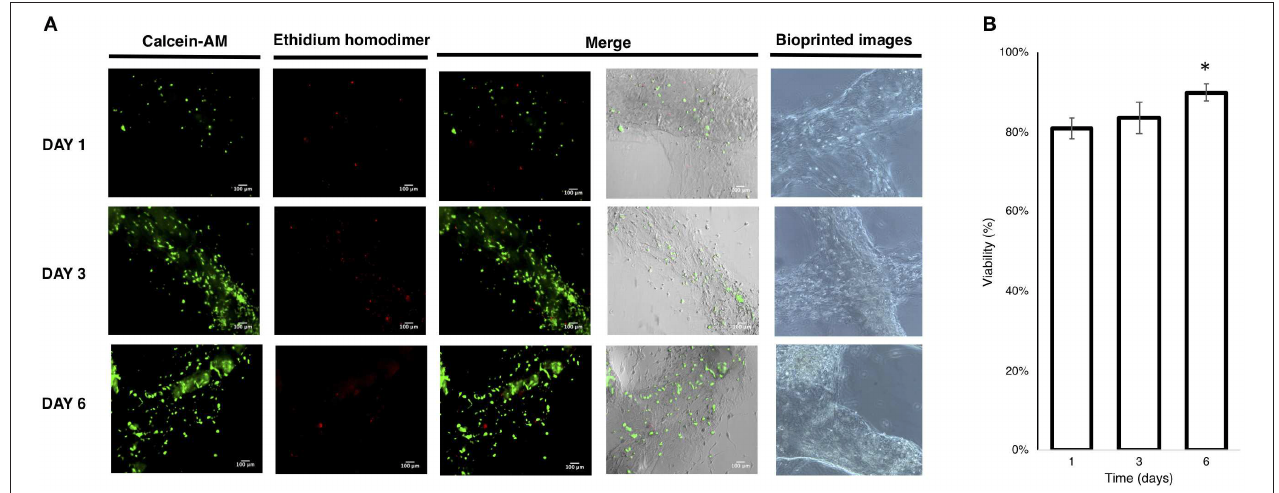
FIGURE 7 | (A) Live/Dead imaging of bioprinted U87 cells; (B) viability of bioprinted cells. (Mean ± SD One-way ANOVA, n = 3: * p <